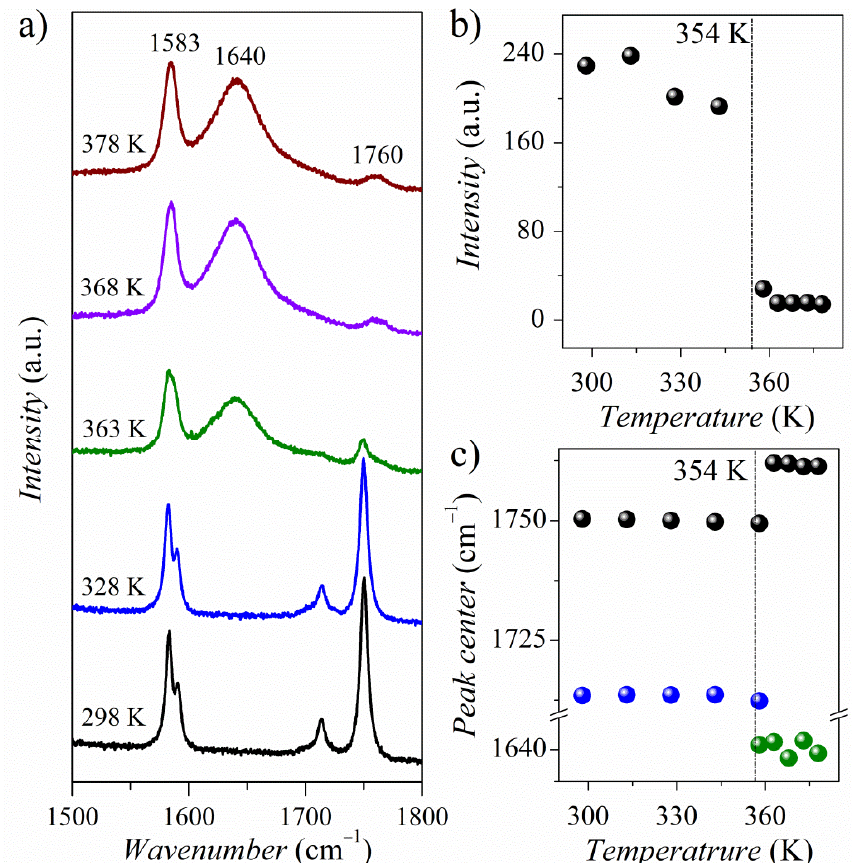
Figure 13. Temperature variation of Raman spectra of the PyrHem × H 2 O ( a ), the temperature dependence of the intensity of the 1760 cm − 1 band ( b ), and the temperature dependence of the positions of the Raman bands ( c ).